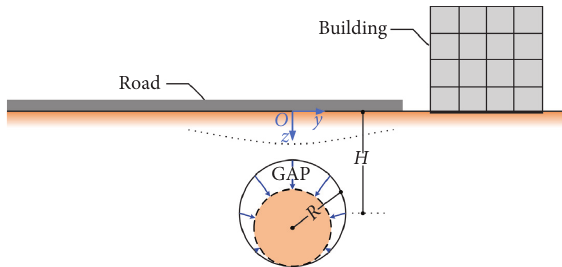
Figure 6: Road and building.